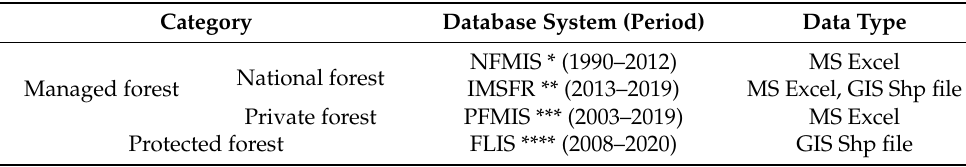
Table 1. Source of data collected from different database